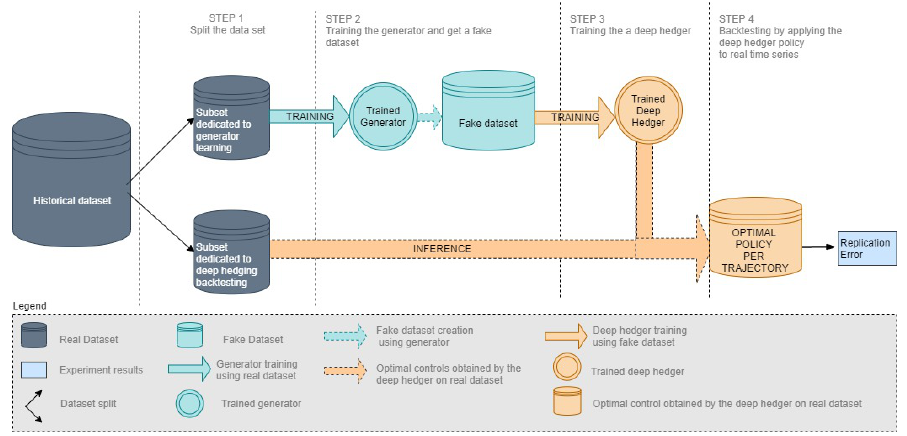
Figure 3. Model-free deep hedger